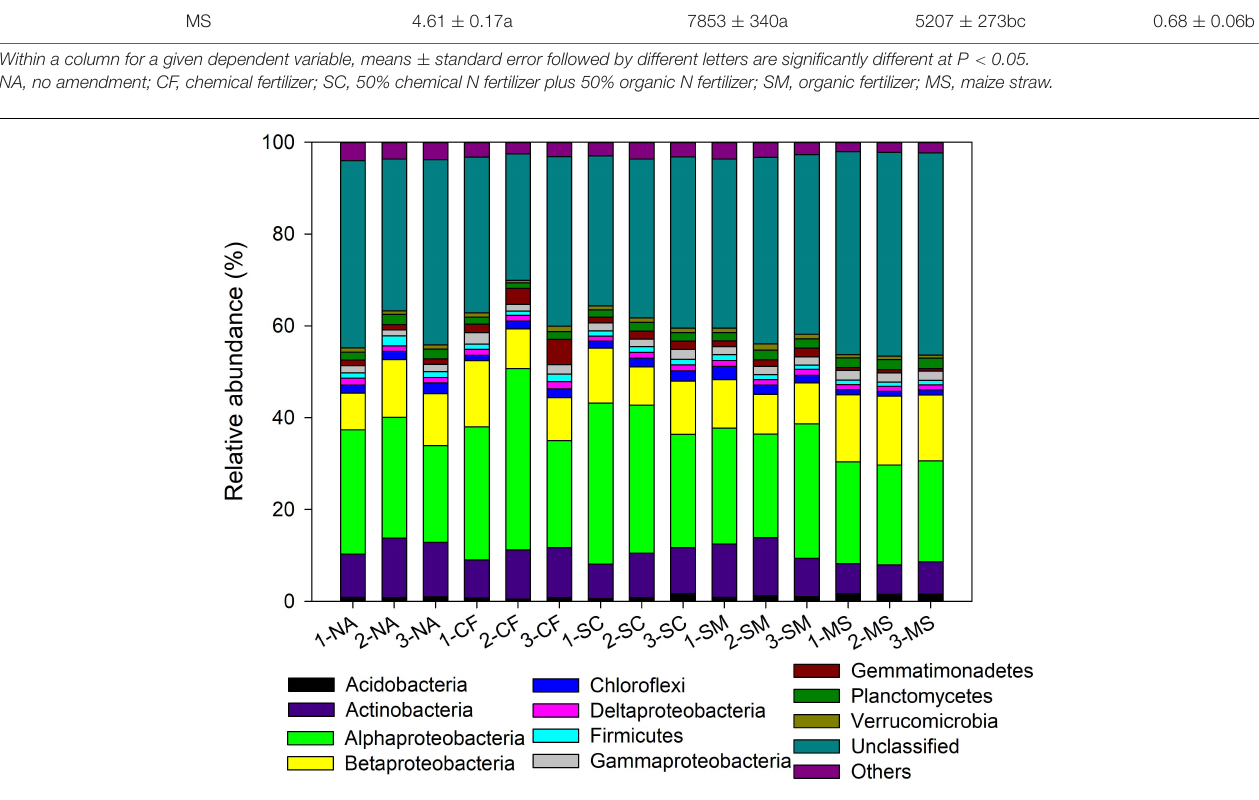
bacterial community, CEE, and maize yield. The autotrophic bacterial community had strong positive relationships with CEE and crop yield according to diversity, composition, and module I of the bacterial network ( Figure 5